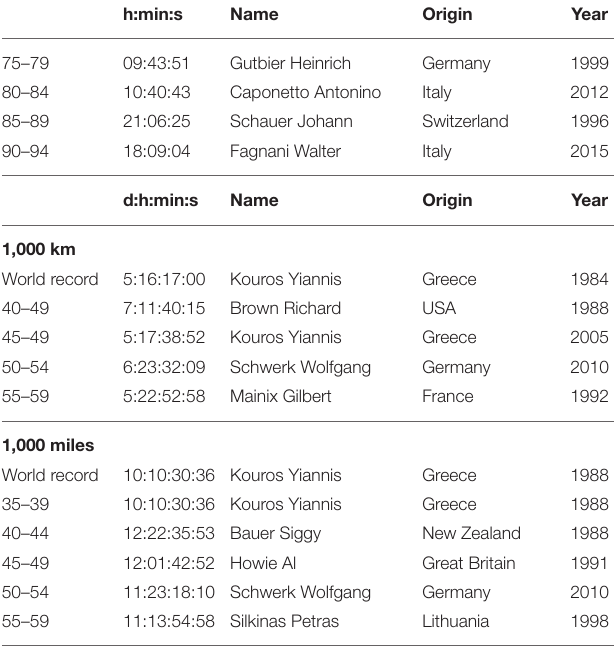
TABLE 3 | World records in male elite and age group athletes in distance-limited races, from